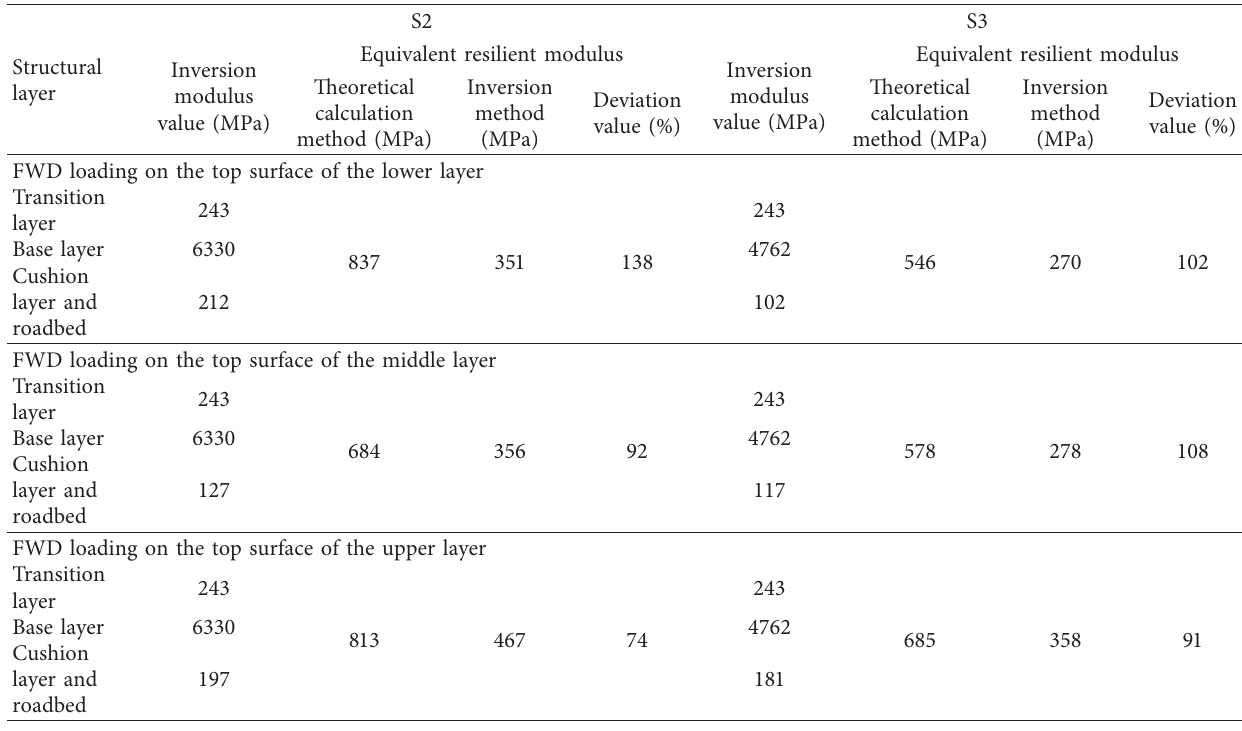
Table 7: Calculation of the equivalent resilient modulus of the top surface of the graded gravel transition layer. Structural